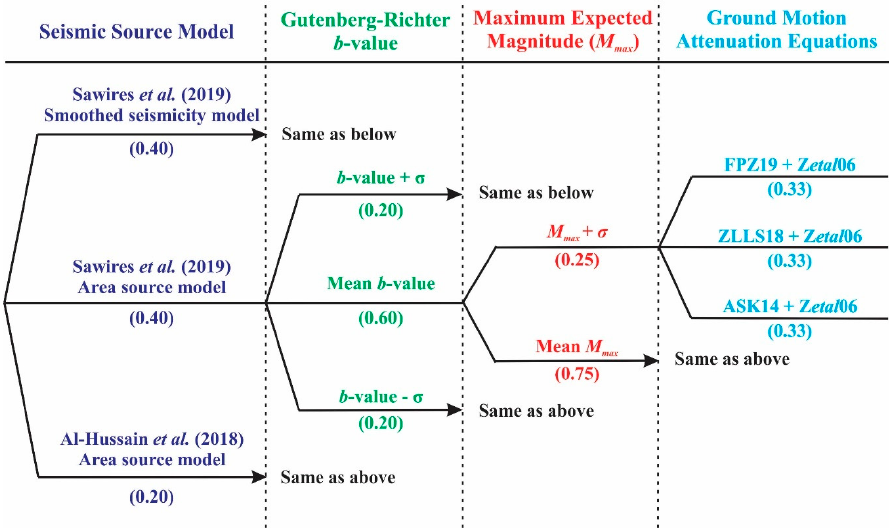
Figure 5. Logic-tree design. Considered weights are shown below each individual branch (FPZ19: [82]; Zetal06: [32]; ZLLS18: [81]; ASK14: [75]).